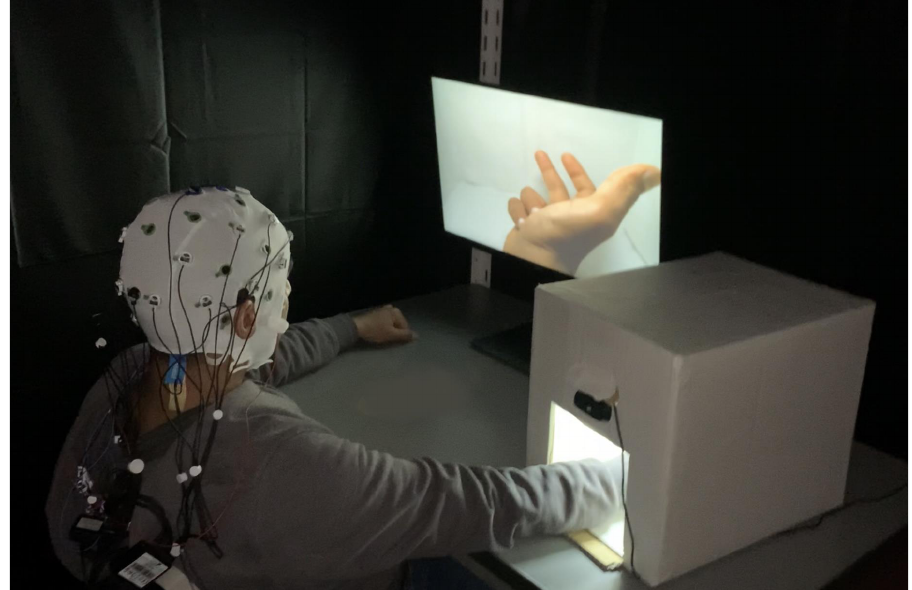
Figure 1. Environment of the EEG experiment. A participant performs the experiment’s tasks while monitoring his movement by watching the video stream on the front screen. The movement displayed on the screen can be delayed according to different time delay conditions.